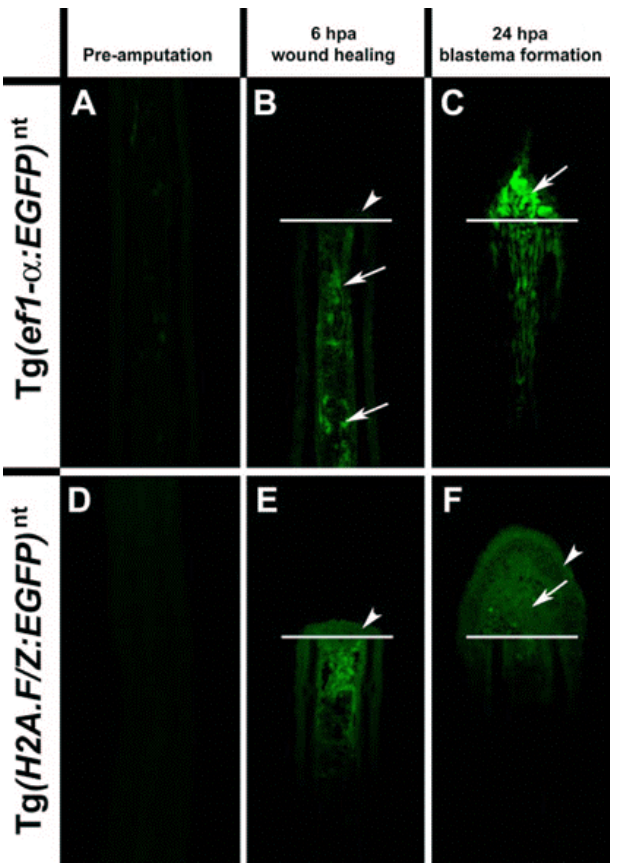
FIGURE 5. Tg (ef1-a:EGFP) nt and Tg (H2A.F/Z:EGFP) nt are expressed in different cell populations during caudal fin regeneration. Sections from Tg (ef1-a:EGFP) nt and Tg (H2A.F/Z:EGFP) nt fins demonstrate the level and location of EGFP expression. (A) Prior to fin amputation, EGFP was not detected in the distal fin. (B) During wound epithelium formation (6 hpa), EGFP is weakly expressed in mesenchymal cells (arrows) proximal to the amputation plane (represented by the white line), but is not detected in the wound epithelium (arrowhead). (C) During blastema formation (24 hpa), EGFP expression is intense in the developing blastema (arrow) and weakly expressed in the disorganized mesenchyme proximal to the amputation plane (represented by the white line). EGFP is not detected in the surrounding wound epithelium. (D) Similar to Tg (ef1-a:EGFP) nt , EGFP is not detected in the distal region of Tg (H2A.F/Z:EGFP) nt fins prior to amputation. (E) During wound healing, EGFP is weakly expressed in the wound epithelium (arrowhead) and underlying mesenchyme. (F) During blastema formation, EGFP is diffusely expressed at moderate levels in both the forming blastema (arrow) and surrounding wound epithelium